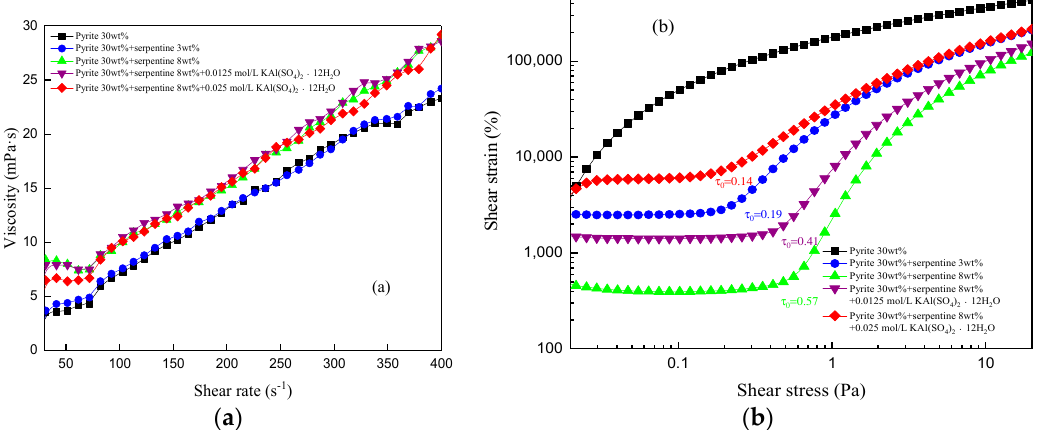
Figure 7. The ( a ) apparent viscosity-shear rate curves and ( b ) the shear strain-shear stress curves of pyrite and serpentine under different conditions (pH = 9.0).